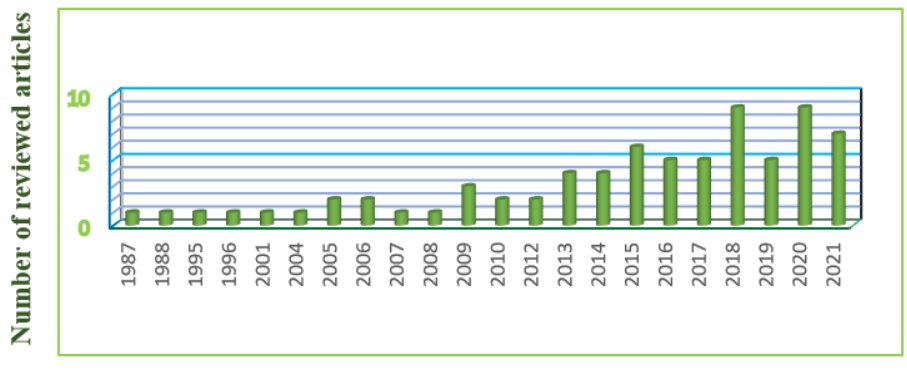
Figure 1. Search strategy and filtering process.